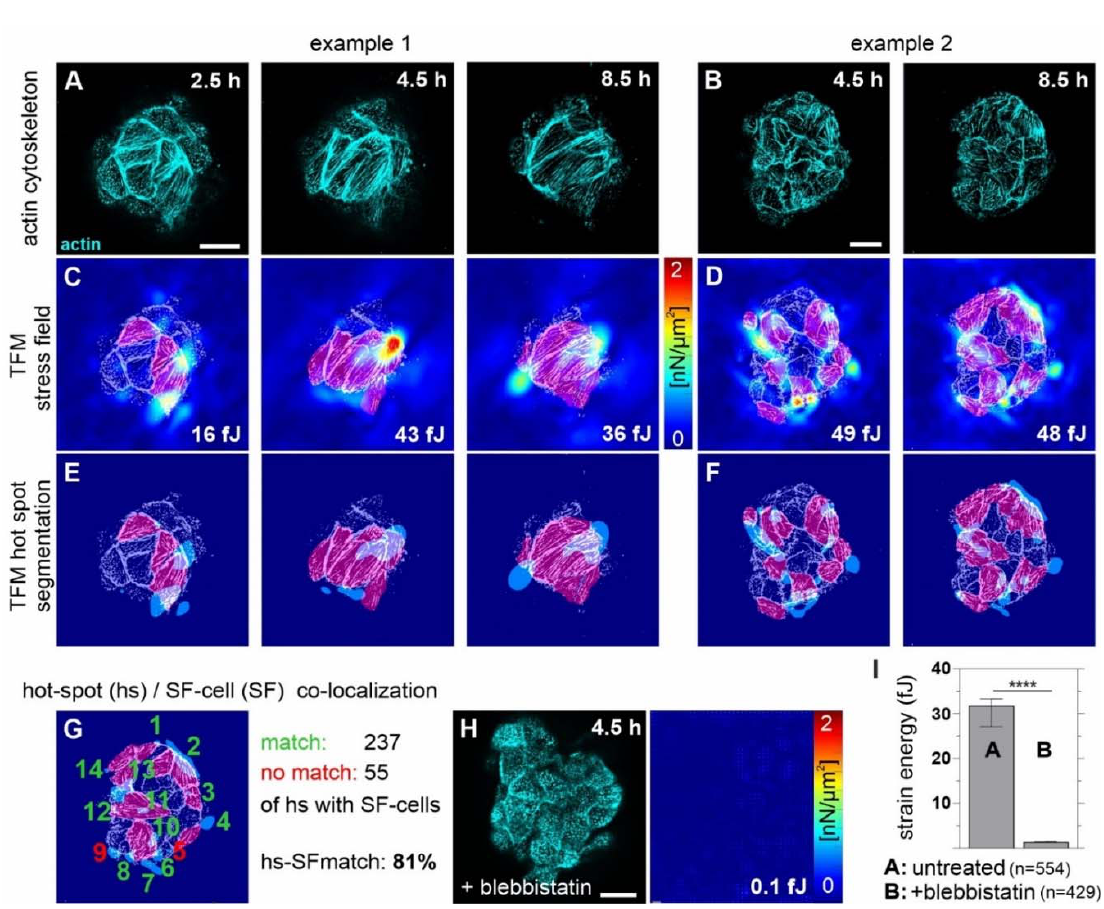
Figure 7. SF cells of invasion-triggered breast acini exert force hot spots on the acinus–BM–ECM interface. TFM image sequences show mechanical stress at the BM–substrate interface exerted by MCF10A/RFP-LifeAct acini (ld-BM, +EGF) on 12 kPa substrates over time. ( A , B ) Confocal images of the acinus–ECM interface representing the actin cytoskeleton. ( C , D ) Matching stress maps (linear lookup table for pseudo-color display) used to calculate total strain energy within the field of view (indicated by white numbers in ( C , D , H )). SF cells were marked manually (magenta). The stress map at one hour for Example 1 is provided in Supplementary Figure S4A. ( E , F ) Hot spots (hs) in stress maps (light blue patches) were segmented automatically and counted for the spatial correlation with SF cells. ( G ) The representative image illustrates the counting procedure and the quantitative result of hot spots and stress coherence (in total 292 hot spots of four independent analyzed acini (30 images)). Hs segmentation (light blue patches) and counting (green and red numbers) was carried out every two hours for each acinus within a measuring period of 18–20 h. The localization of 237 hot spots matched with SF cells (green numbers), and 55 did not (red numbers). For a further example of matching hot spots with SF, see Supplementary Figure S4C. ( H ) Representative acinus with MS cell treated with blebbistatin (25 µ M). Left: actin cytoskeleton, right: TFM stress map (for additional time points, see Supplementary Figure S4B). ( I ) Calculated strain energies (SE) of acini treated with blebbistatin compared to untreated samples. The graph shows the SE values measured over a period of 18–20 h (images were taken every seven minutes). Bars show median with 95% confidence interval; Untreated acini: median SE = 32 fJ ( n = 4, in total 554 images); Blebbistatin treated acini: median SE = 1.4 fJ ( n = 4, in total 429 images); DMSO control (not shown): median SE = 45 fJ ( n = 3, in total 438 images). Mann–Whitney U-test with: **** = p < 0.0001. Scale bars: 20 µ m. For complete image series of the actin dynamics, see Supplementary Movies S6 and